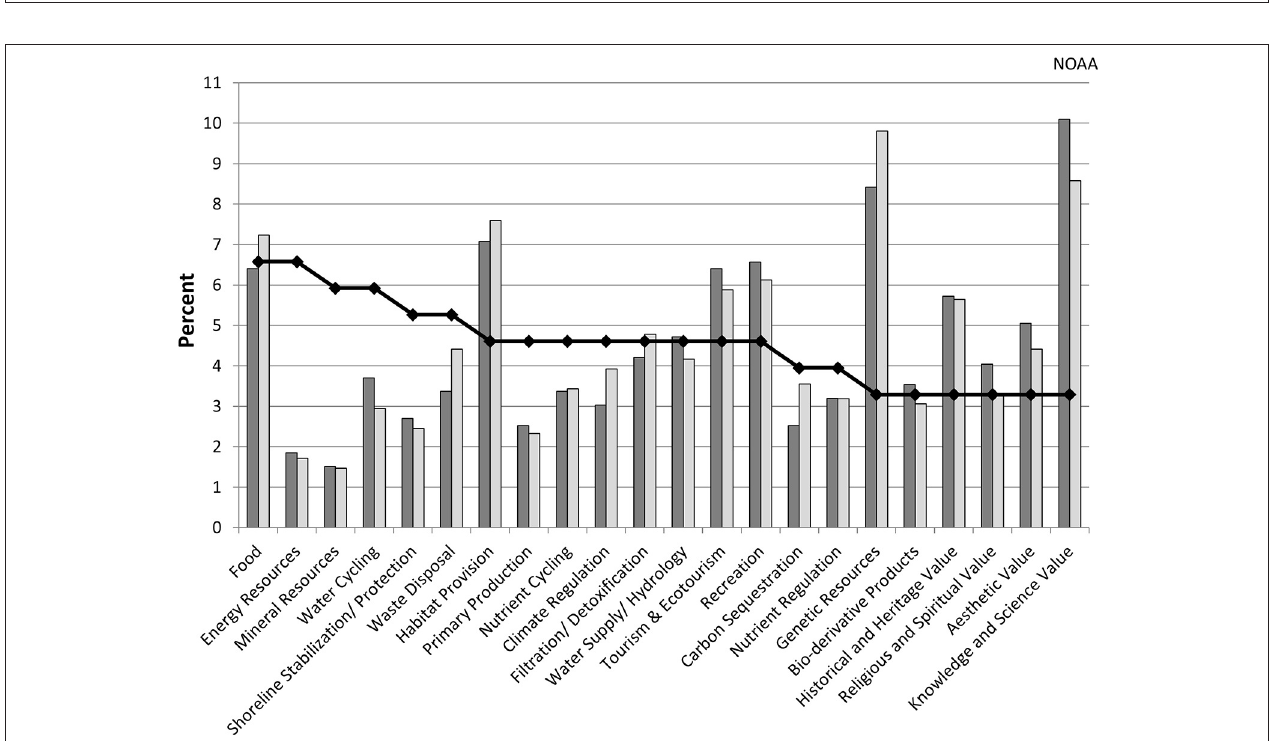
FIGURE 2 | The normalized value of all the mandates collectively is shown for all NOAA mandates. The dark bars reflect of the number of mandates relevant to each of the identified EGS (count). The light bars reflect the collective degree to which the mandates address each EGS, with the degree scored on a high, moderate, low, minimal scale (4, 3, 2, 1 respectively). The line shows the normalized organizational priority of the EGS for NOAA expressed as a percent.